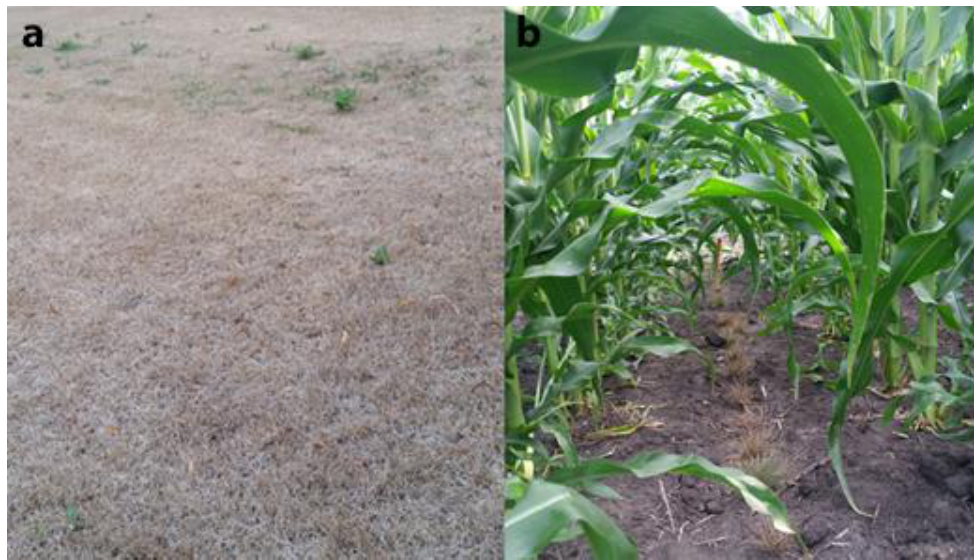
Figure 8. Summer dormancy as shown in browned Kentucky bluegrass following an extended period of extreme drought (a) and in Sandburg bluegrass grown with maize